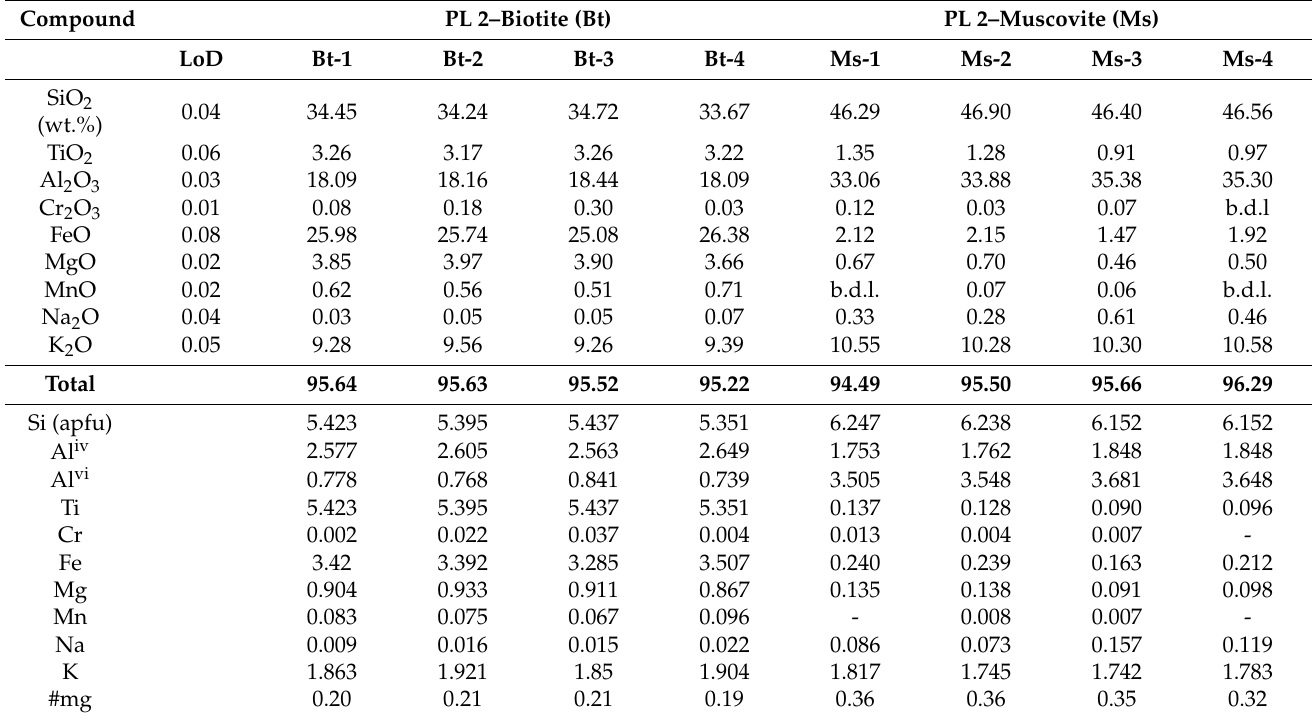
Table 1. Representative microprobe analyses of biotite and muscovite with their crystal-chemical formulas recalculated for 22 O 2 − .